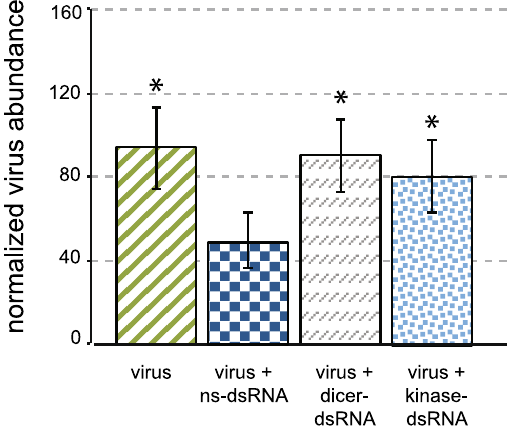
Figure 5. Reduced expression of two honey bee genes resulted in increased virus abundance. To further investigate the role of dicer and cyclin - dependent kinase in honey bee antiviral defense, we utilized RNAi- mediated gene knock down to reduce their expression (Supplementary Fig. S10) and qPCR to determine the impact on virus abundance. SINV-GFP abundance in kinase and dicer specific dsRNA-treated bees at 72 hpi was increased by 48% ( * p < 0.05) and 44% ( * p < 0.05), respectively, compared to the ns-dsRNA control,